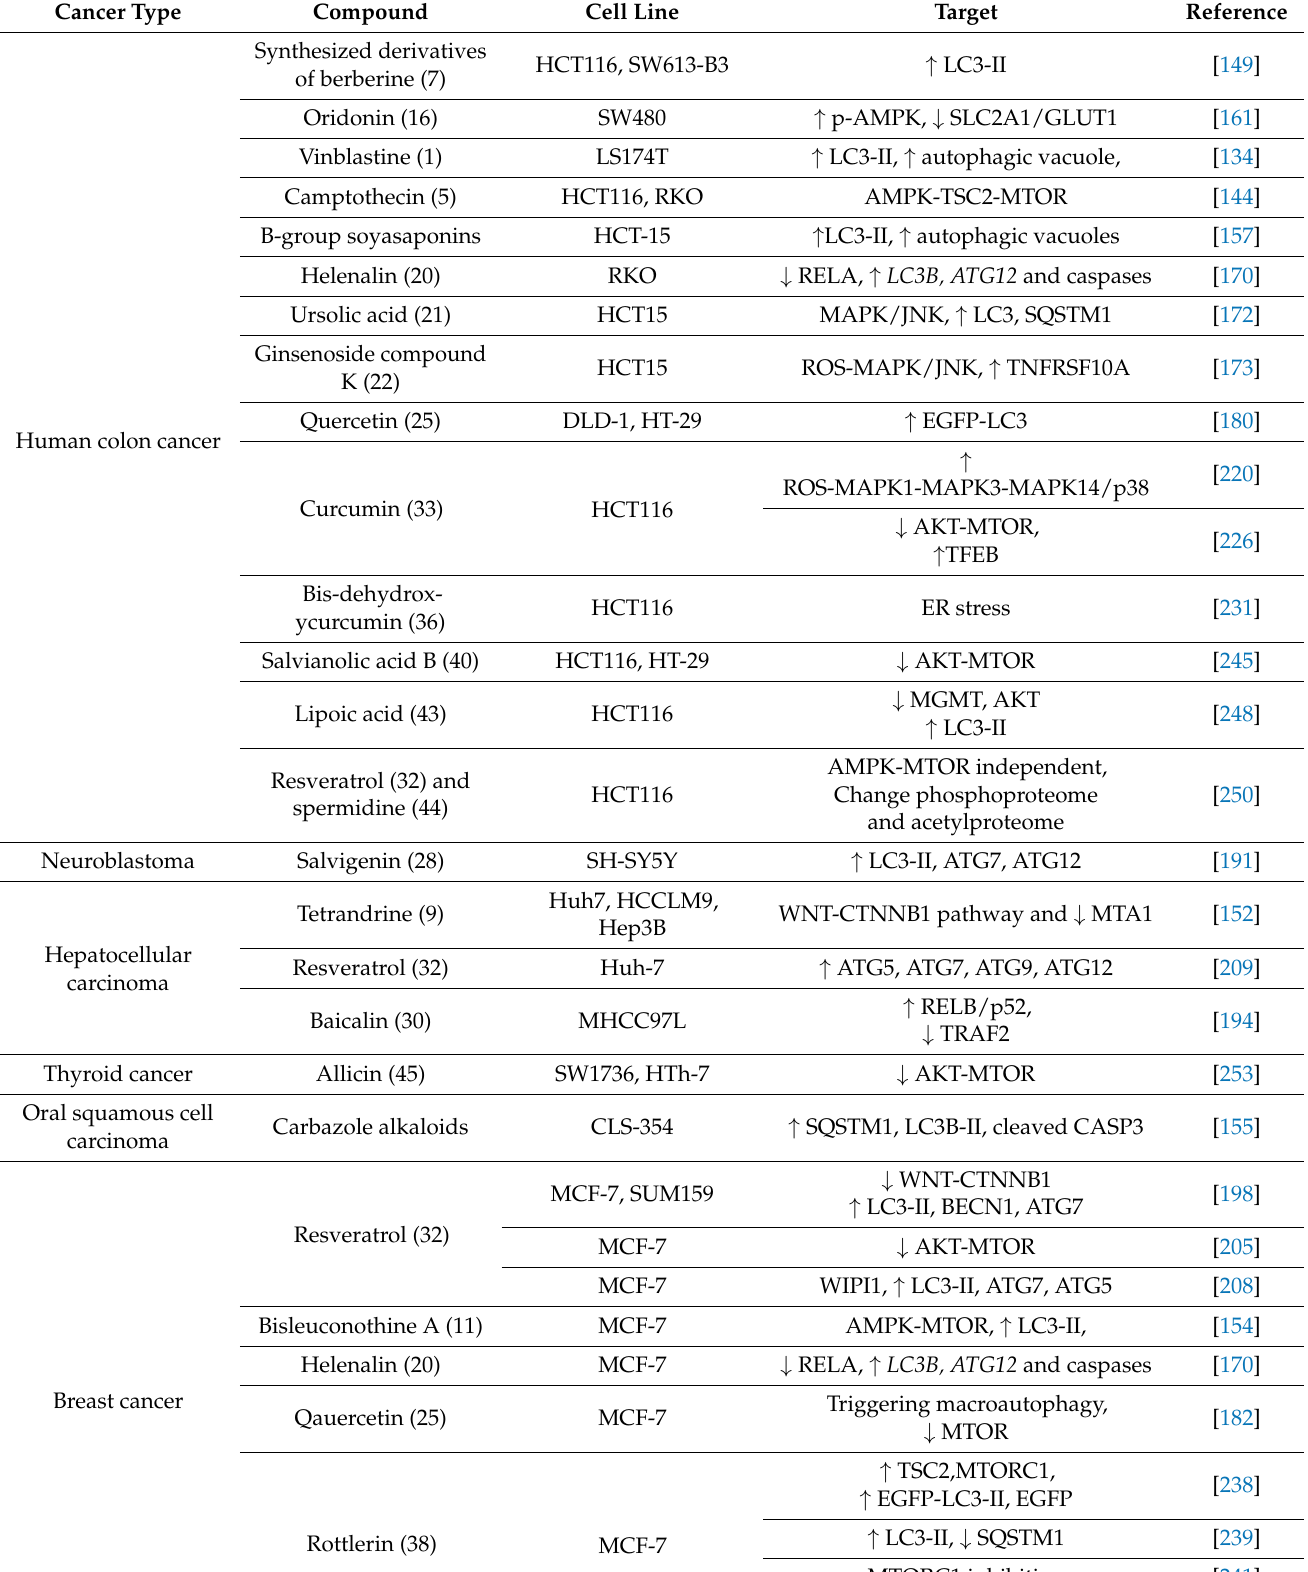
Table 1. Natural autophagy modulators and their effect on signal transduction